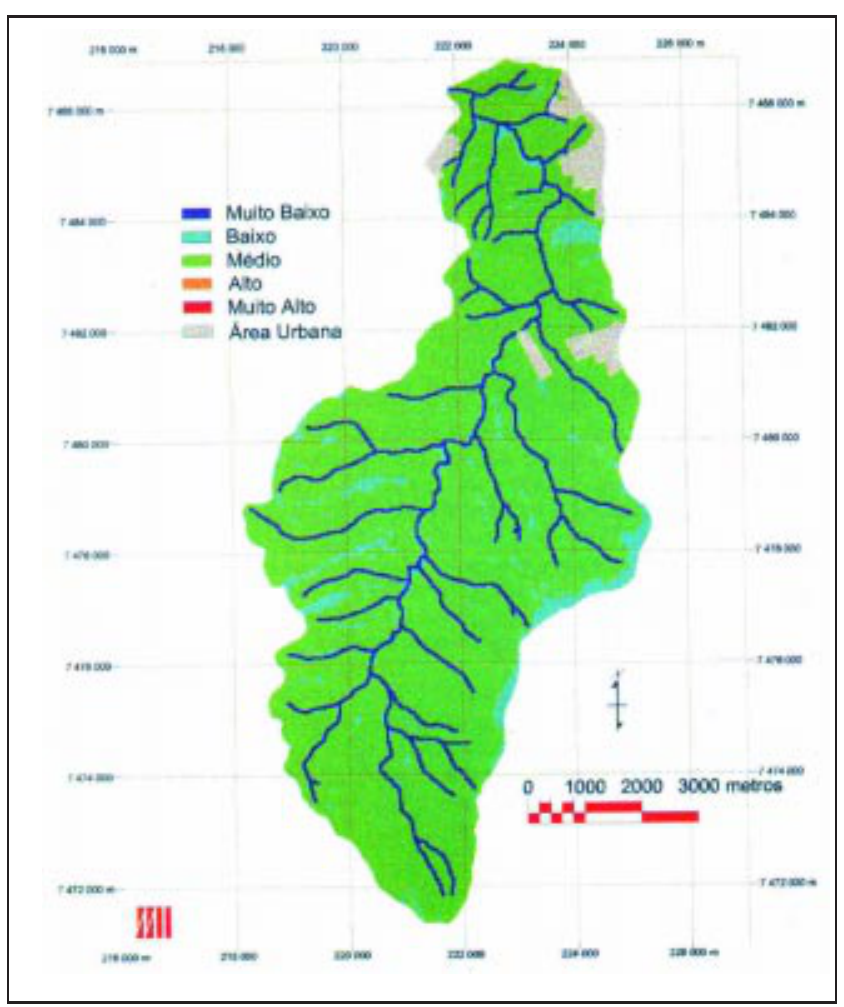
Figura 3. Mapa de risco de degradação das terras para o cenário de uso planejado (SIG- TNTmips